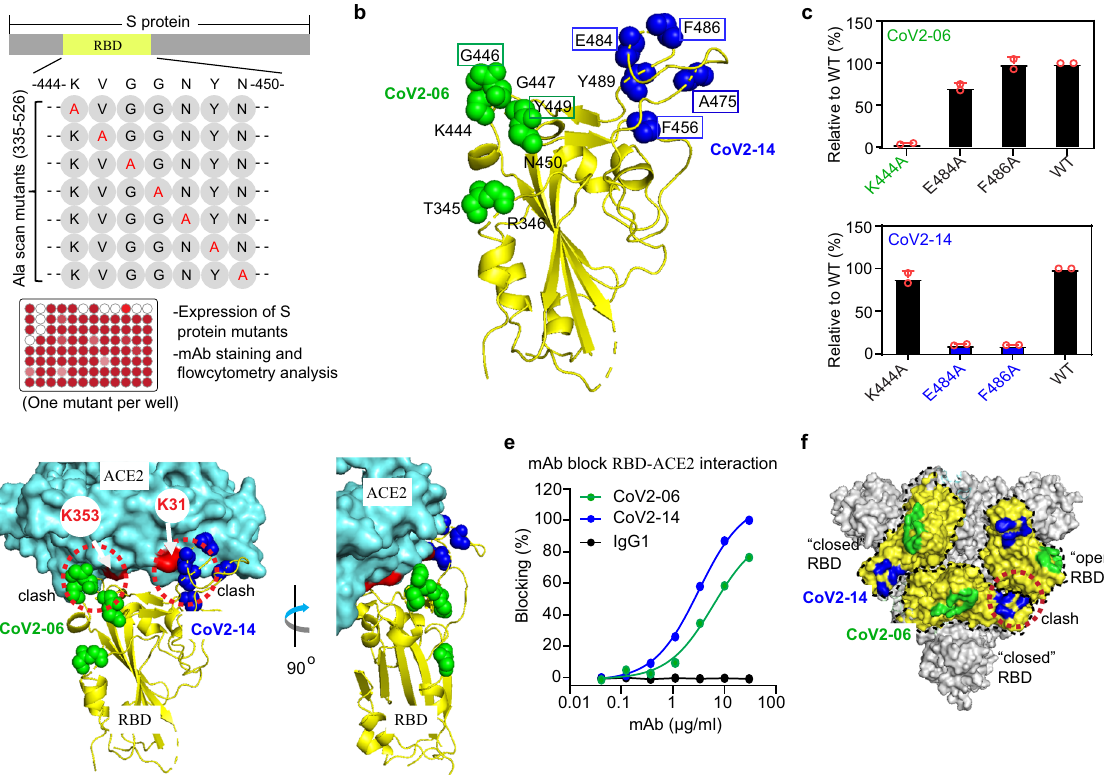
Fig. 3 Molecular determinants on the RBD for CoV2-06 and CoV2-14 binding and the mechanism of neutralization. a Schematic diagram of the shotgun and high-throughput epitope mapping strategy. Representative alanine scan mutations in the RBD region of S and the critical procedures for mapping are shown. b The residues critical for CoV2-06 and CoV2-14 are shown as green and blue spheres, respectively, on a structure of RBD (PDB: 6M0J). The residues that make direct contact with ACE2 are boxed. c CoV2-06 or Cov2-14 binding to the sCoV2-RBD proteins with indicated mutations. Error bars indicate SD of duplicates wells. d The critical residues for CoV2-06 and CoV2-14 at the interface of RBD-ACE2 complex (PDB: 6M0J). The arrows indicate the K353 and K31 residues in ACE2, which are two virus-binding hotspots. The dashed circles indicate the steric clash of the two mAbs and ACE2 in binding to the RBD. e Dose-dependent blocking of RBD binding to ACE2 by CoV2-06 and Cov2-14. f The landscape of CoV2-06 and CoV2-14 epitopes on the trimeric S structure (PDB: 6VSB). The RBD in each monomer is outlined and colored in yellow. The CoV2-06 epitope is colored in green and the CoV2- 14 epitope in blue. The dashed circle indicates a steric clash of CoV2-14 and an adjacent “ open ” RBD in binding to a “ closed ”